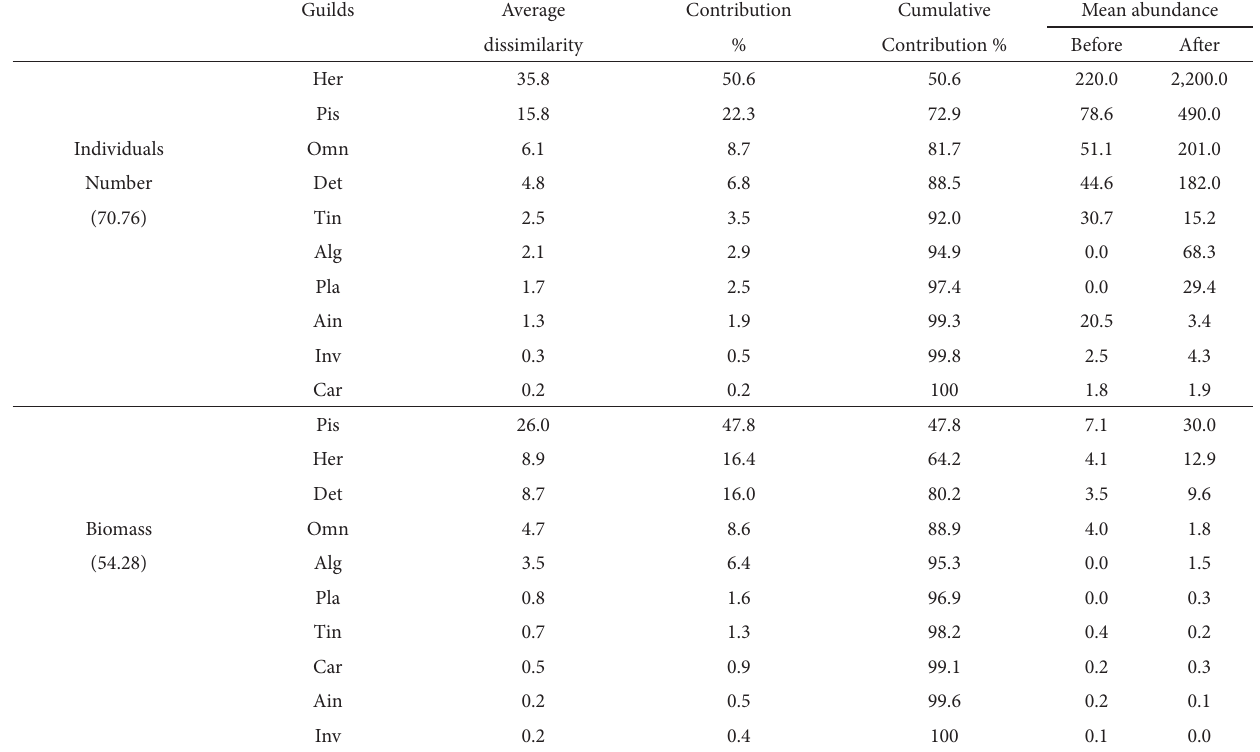
Table 7. Results of the SIMPER analyses for the dissimilarity of the proportion in number and biomass (CPUE) of the trophic guilds along the longitudinal gradient of the Salto Caxias Reservoir, Iguaçu River, before and after the impoundment. (Alg = algivores; Det = detritivores; Her = herbivores; Ain = aquatic insectivores; Tin = terrestrial insectivores; Inv = invertivores; Omn = omnivores; Pis = piscivores; Pla = planktivores; Car =